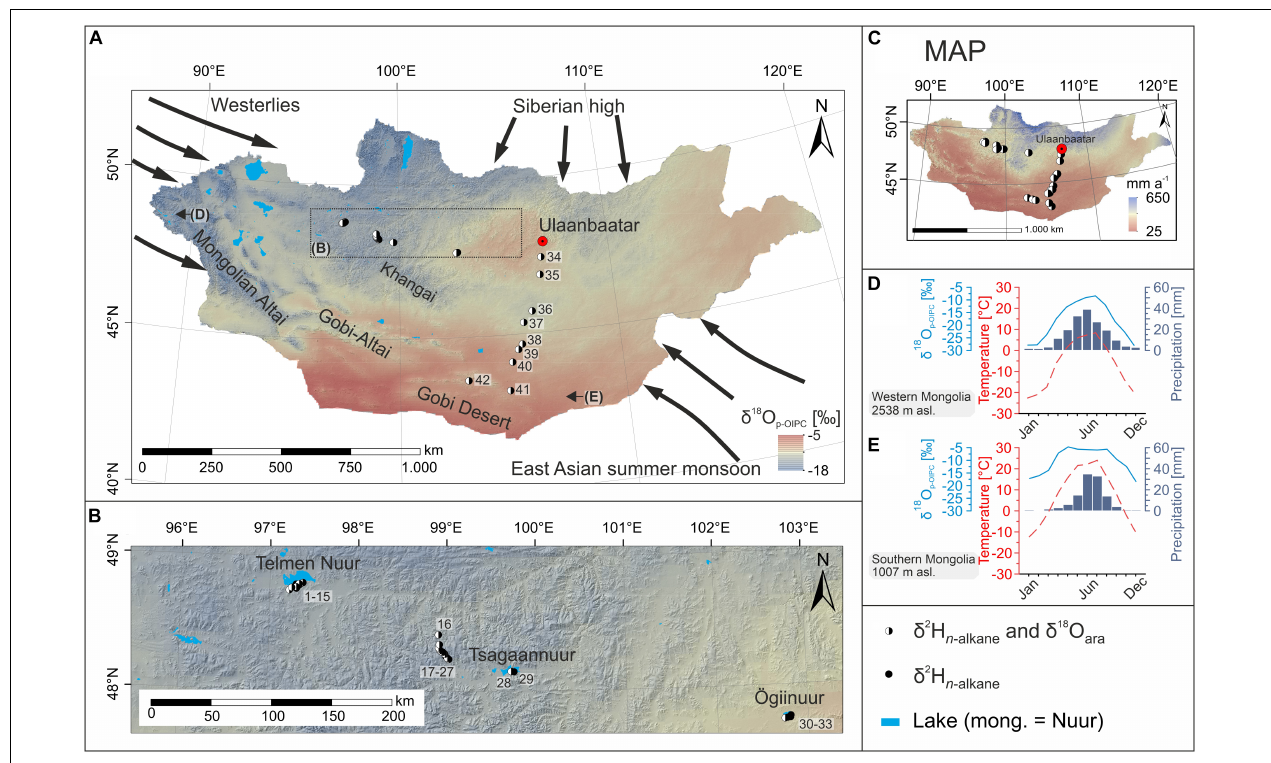
FIGURE 1 | (A) Map of Mongolia showing δ 18 O p - OIPC (Bowen, 2019) and the sampling locations. Black circles indicate samples which were analyzed for δ 2 H n - alkane only, whereas black/white circles indicate samples which were analyzed for δ 2 H n - alkane and δ 18 O ara . (B) Submap showing a closeup of (A) . (C) Map of Mongolia showing mean annual precipitation (Fick and Hijmans, 2017). (D,E) Climate diagrams illustrating the seasonal variability of precipitation and temperature (1970–2000; Fick and Hijmans, 2017), as well as the variability of δ 18 O p - OIPC (Bowen, 2019) for (D) western Mongolia and (E) southern